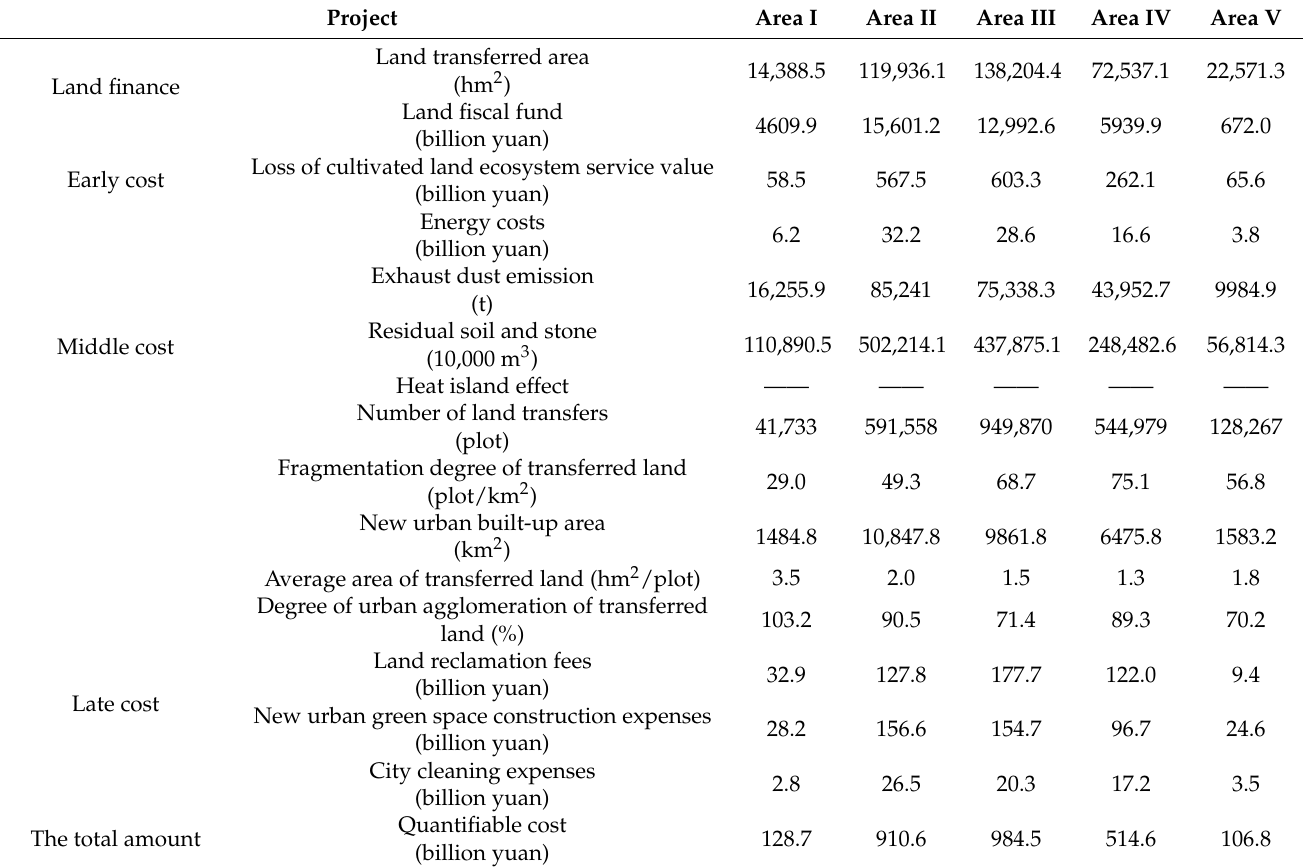
Table 8. Total scale of land fiscal ecological cost in each area from 2003 to